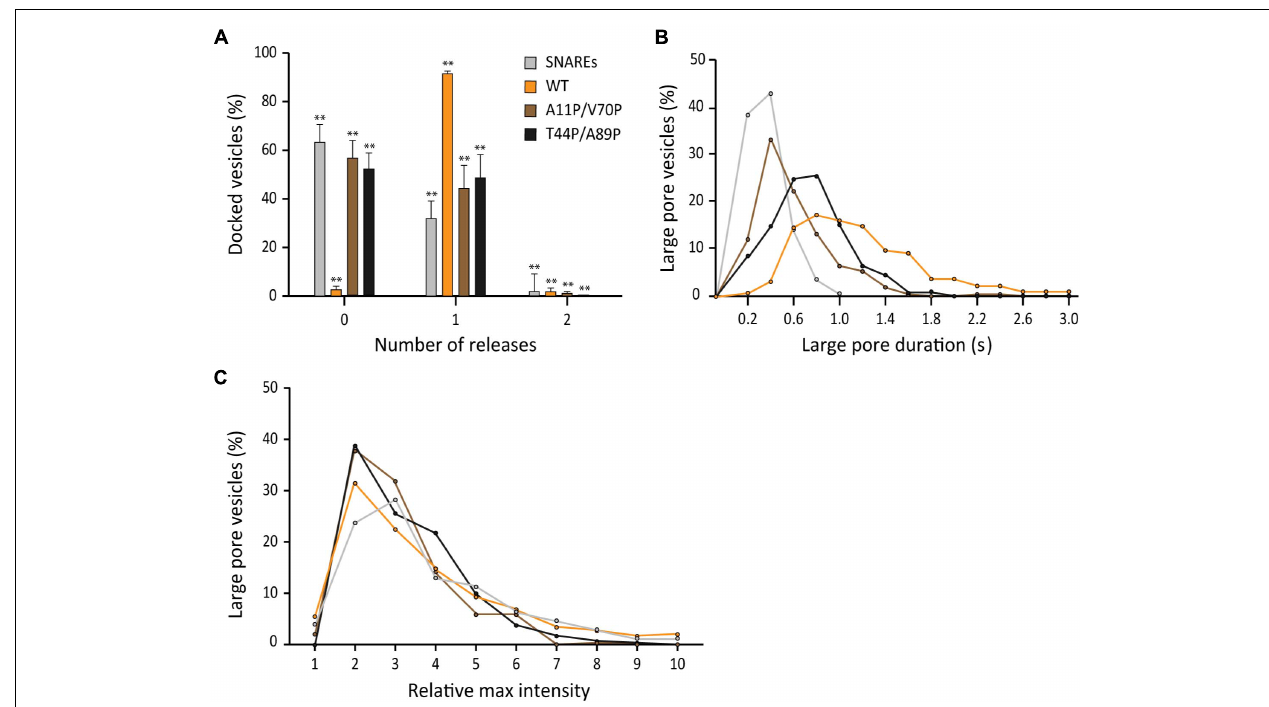
FIGURE 6 | Membrane binding of α S plays a role in stimulating fusion pore expansion. (A) Distribution of number of large pore fusion events for individual docked vesicles. For α S A11P/V70P, 124 release events were detected out of 289 total events from 18 independent measurements. For α S T44P/A89P, 98 large pore fusion events were detected out of 209 total events from 19 independent measurements. Error bars represent standard deviations from means. The data are shown as means ± SD. ∗∗ p < 0.01 by Student’s t -test; n = 3 independent experiments. (B) Distribution of the duration of the large fusion pore. (C) Distribution of relative maximum intensities of large pore fusion